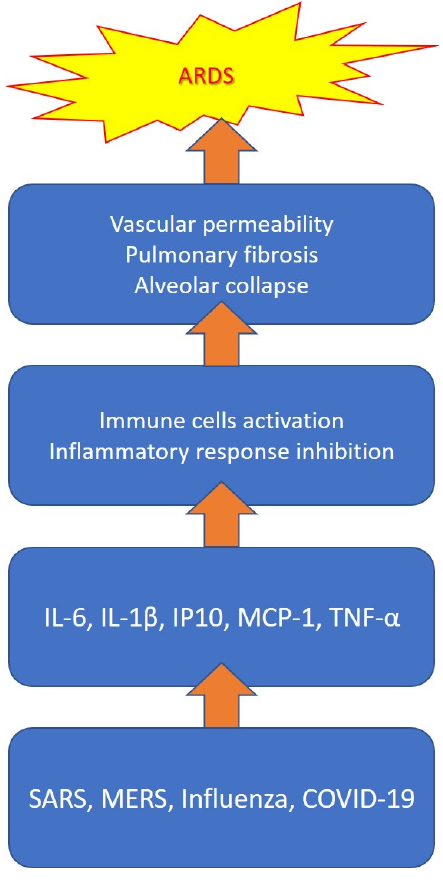
Figure 2. Cytokine storm during viral